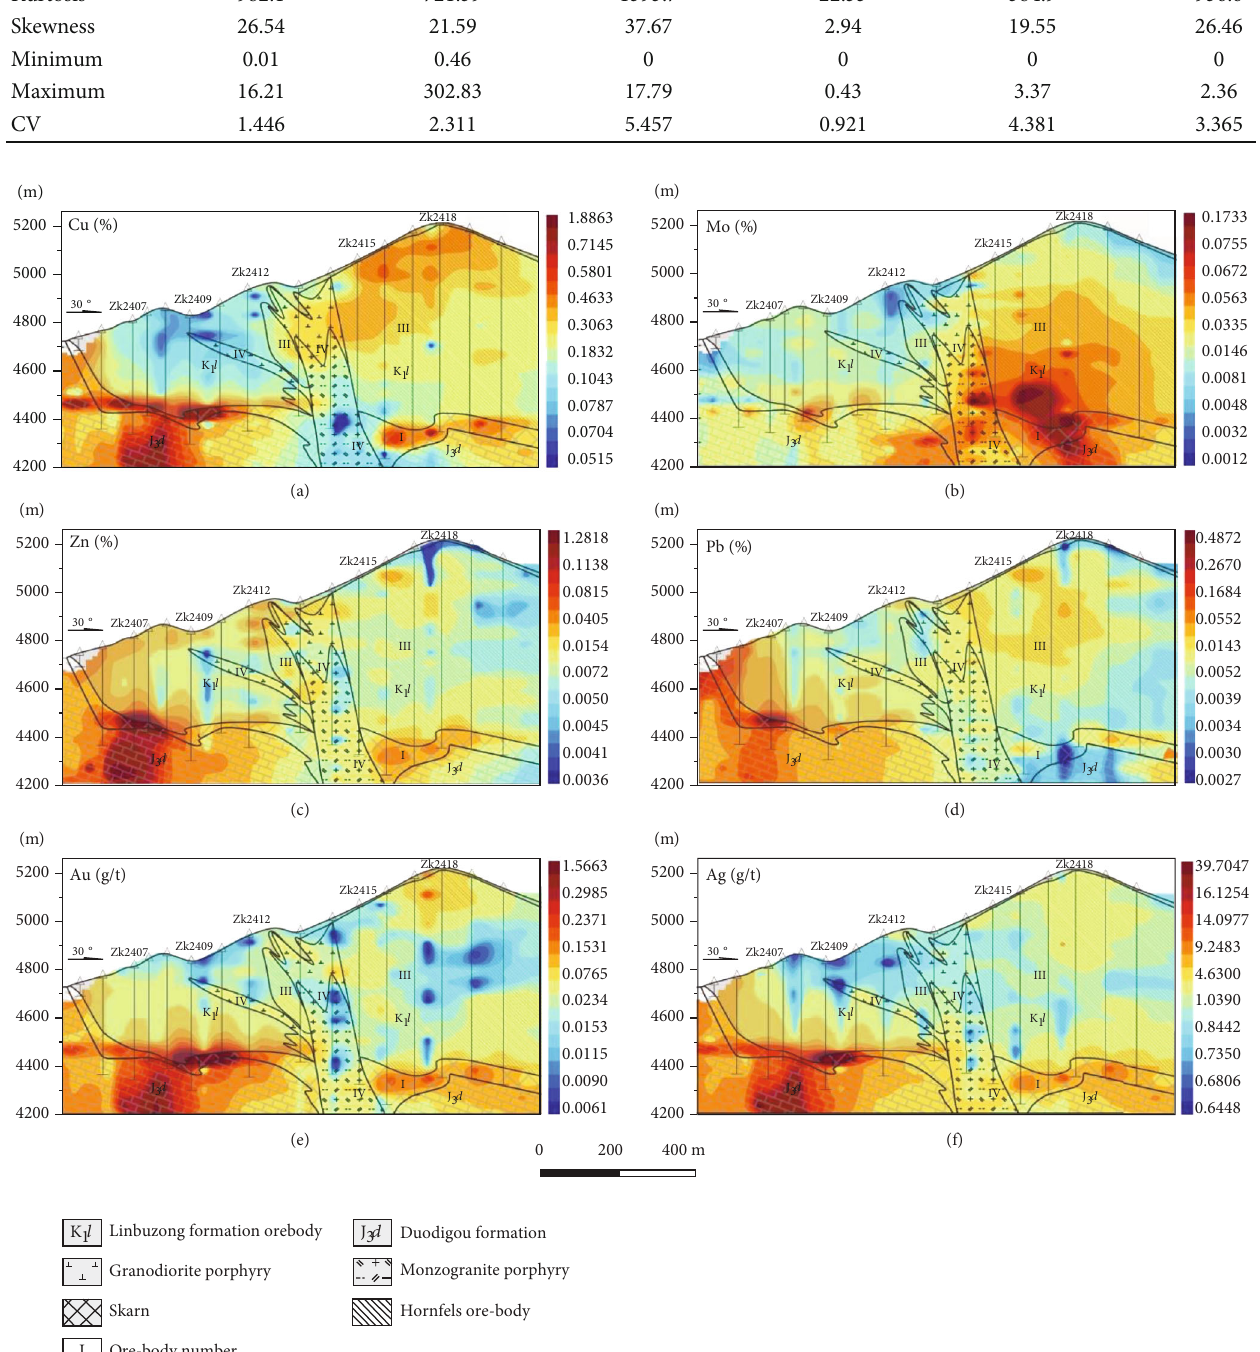
Figure 5: Distributions of di ff erent elements in the #24 exploration pro fi le.